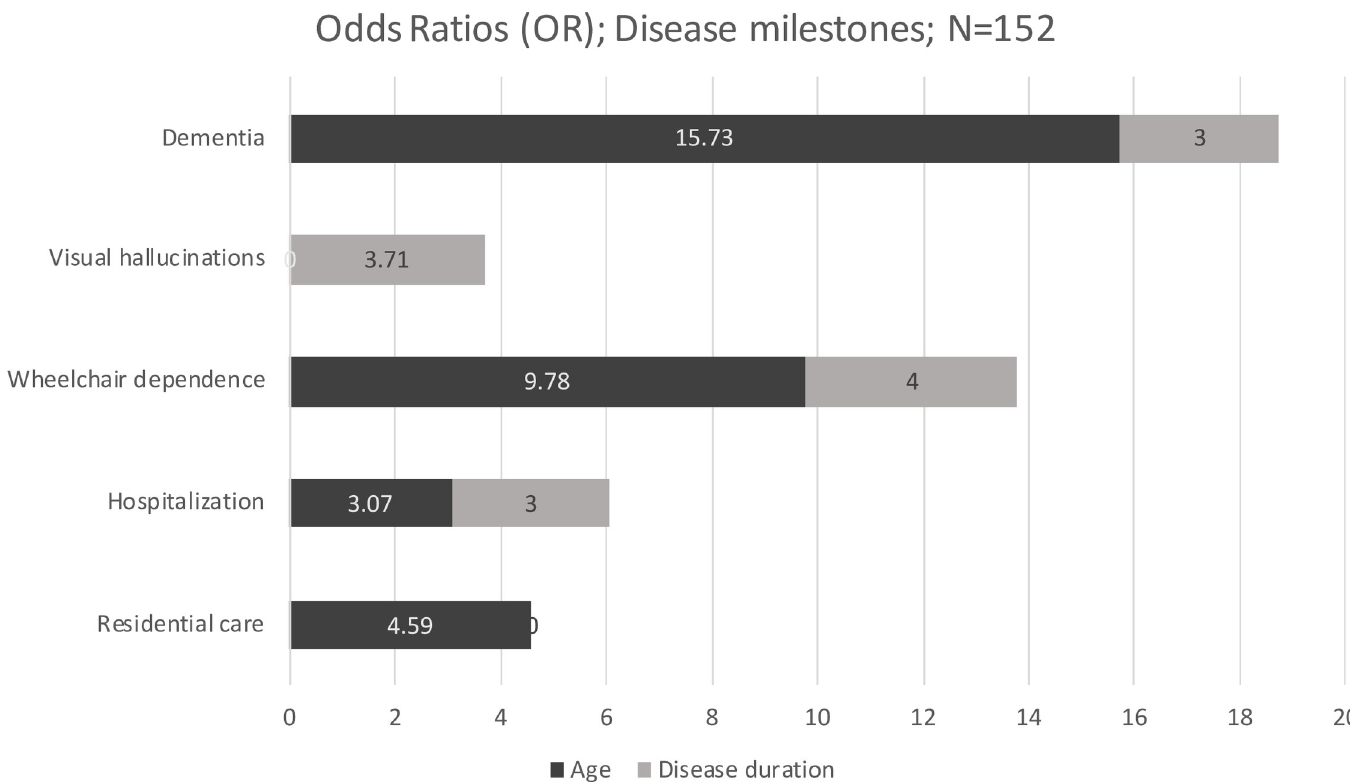
Fig 3. Radar graph of odds ratio visualization for disease milestones difference by age and disease duration.